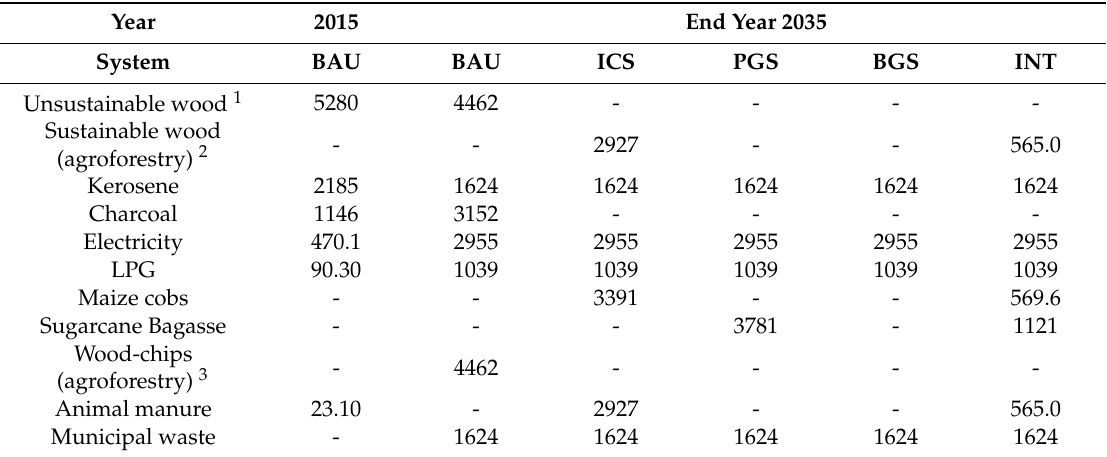
Table A2. Energy inputs in the fuel production life-cycle stage (TJ), considering each fuel